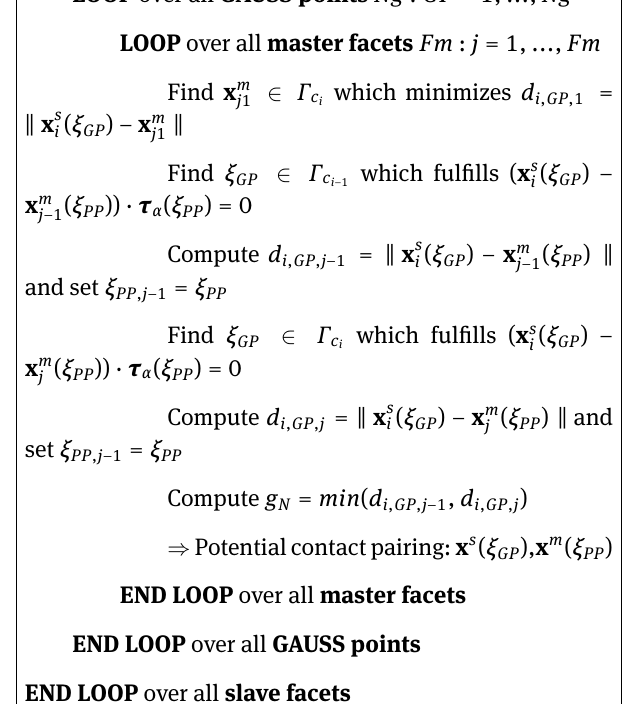
Table 2: Contact search for potential pairings.